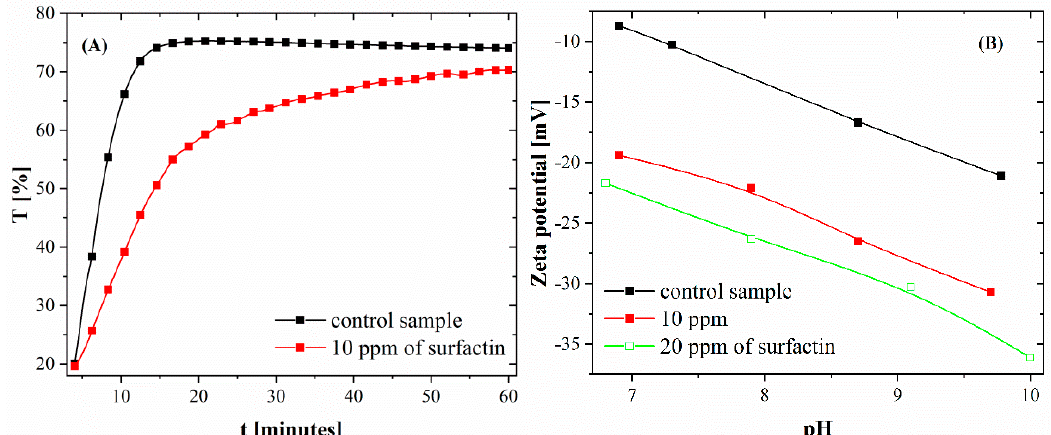
Figure 1. ( A ) T (%) value changes during the time of reaction. ( B ) Zeta potential of calcium carbonate precipitated at various surfactin concentrations after 24 h of ageing (NaCl concentration was 1 mM, standard deviation for zeta potential values was lower than 1 mV).